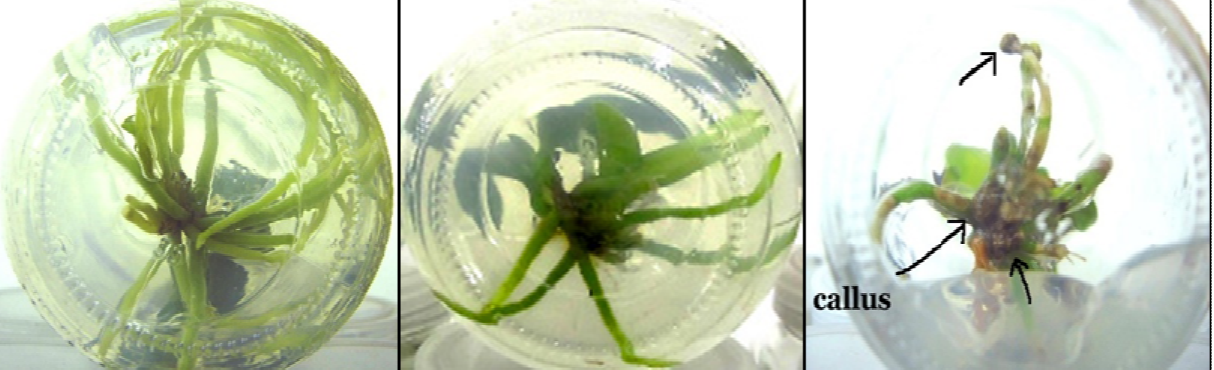
Fig. 2. In vitro better root formation of orchid plantlets on 0.1 and 1.0 mg l -1 IBA (from left to right two jars), compared to 3.0 mg l -1 IBA (right jar)